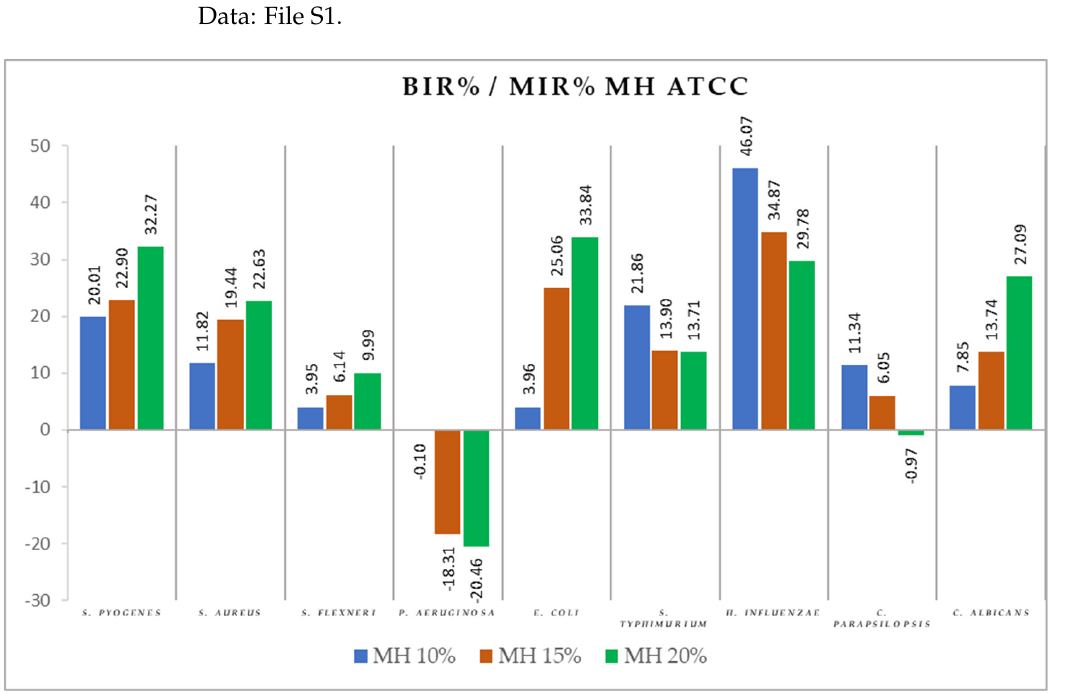
Figure 4. MH antimicrobial activity (expressed as BIR%/MIR%) on ATCC strains.